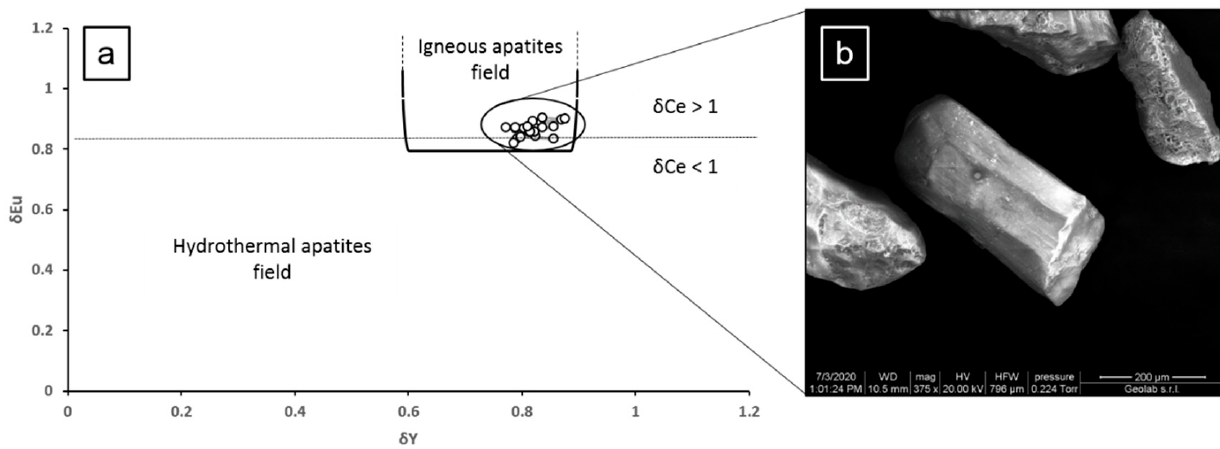
Figure 5. ( a ) Apatite minerals from Fuerteventura carbonatites plotted on δ Eu vs. δ Y diagrams with different igneous and hydrothermal apatite fields using REE criteria ( δ Eu, δ Y, and δ Ce) of Chakhmouradian et al. 2017 [82]. ( b ) Secondary electron (SE) image of some plotted apatite minerals with a typical igneous tapered pill-like shape; scale bar = 200 µ m. In extrusive or shallow intrusive carbonatites, apatite occurs as euhedral prismatic phenocrysts and/or groundmass crystals [82]. On the contrary, igneous apatite from plu- tonic carbonatites normally occurs with smooth contours and a tapered pill-like shape